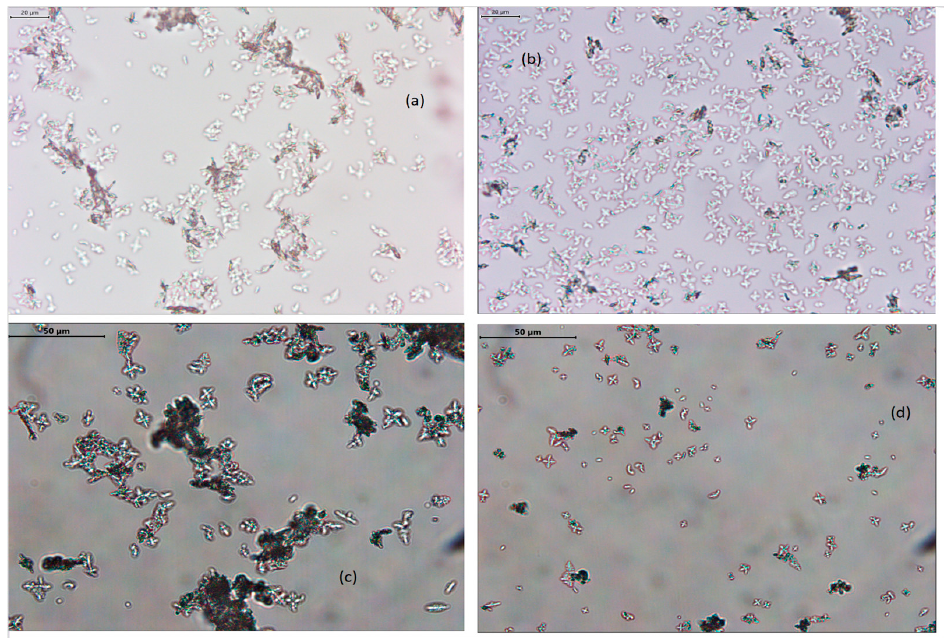
Figure 7. Microscopic photographs of crystals for various Re: ( a ) Re = 800, ( b ) Re = 1000, ( c ) Re = 2750, ( d ) Re = 4500 (red circles mark broken crystals).